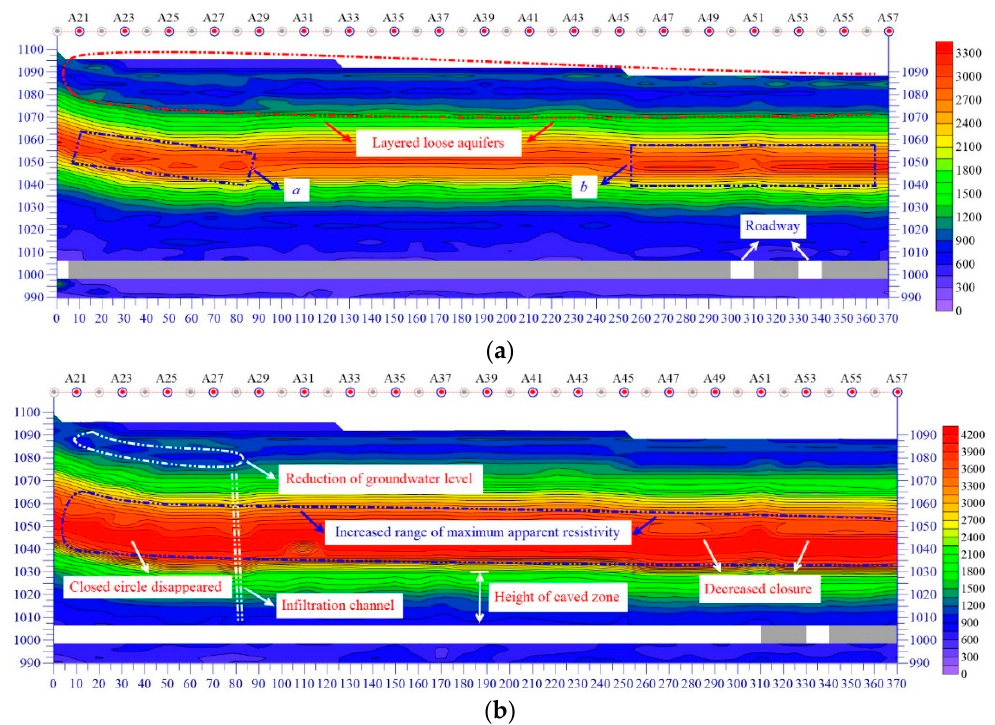
Figure 7. A pparent resistivity (AR) contour of line A before and after mining. ( a ) Before mining and